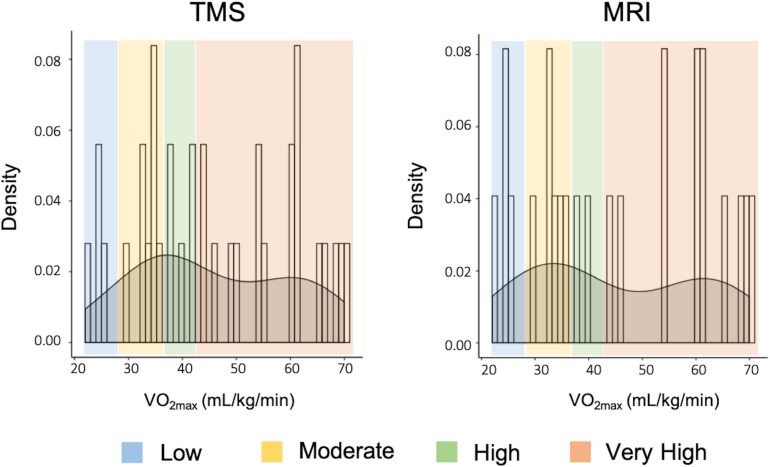
Distribution of VO2max and fitness levels in both TMS and MRI samples.